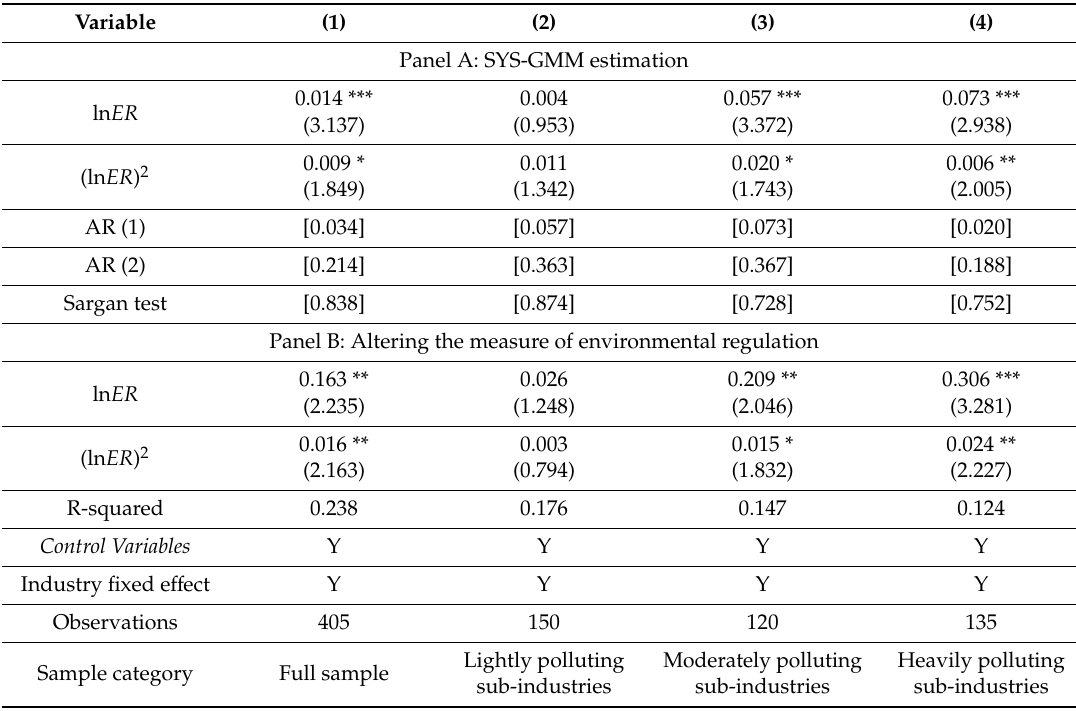
Table 4. Results of the robustness